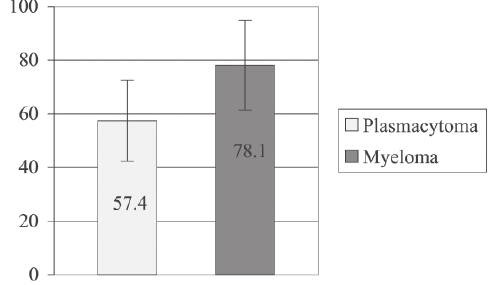
Table 4 - Age (in years) in patients with plasmacytoma at the time of the first visit vs patients with plasmacytoma that progressed to multiple myeloma